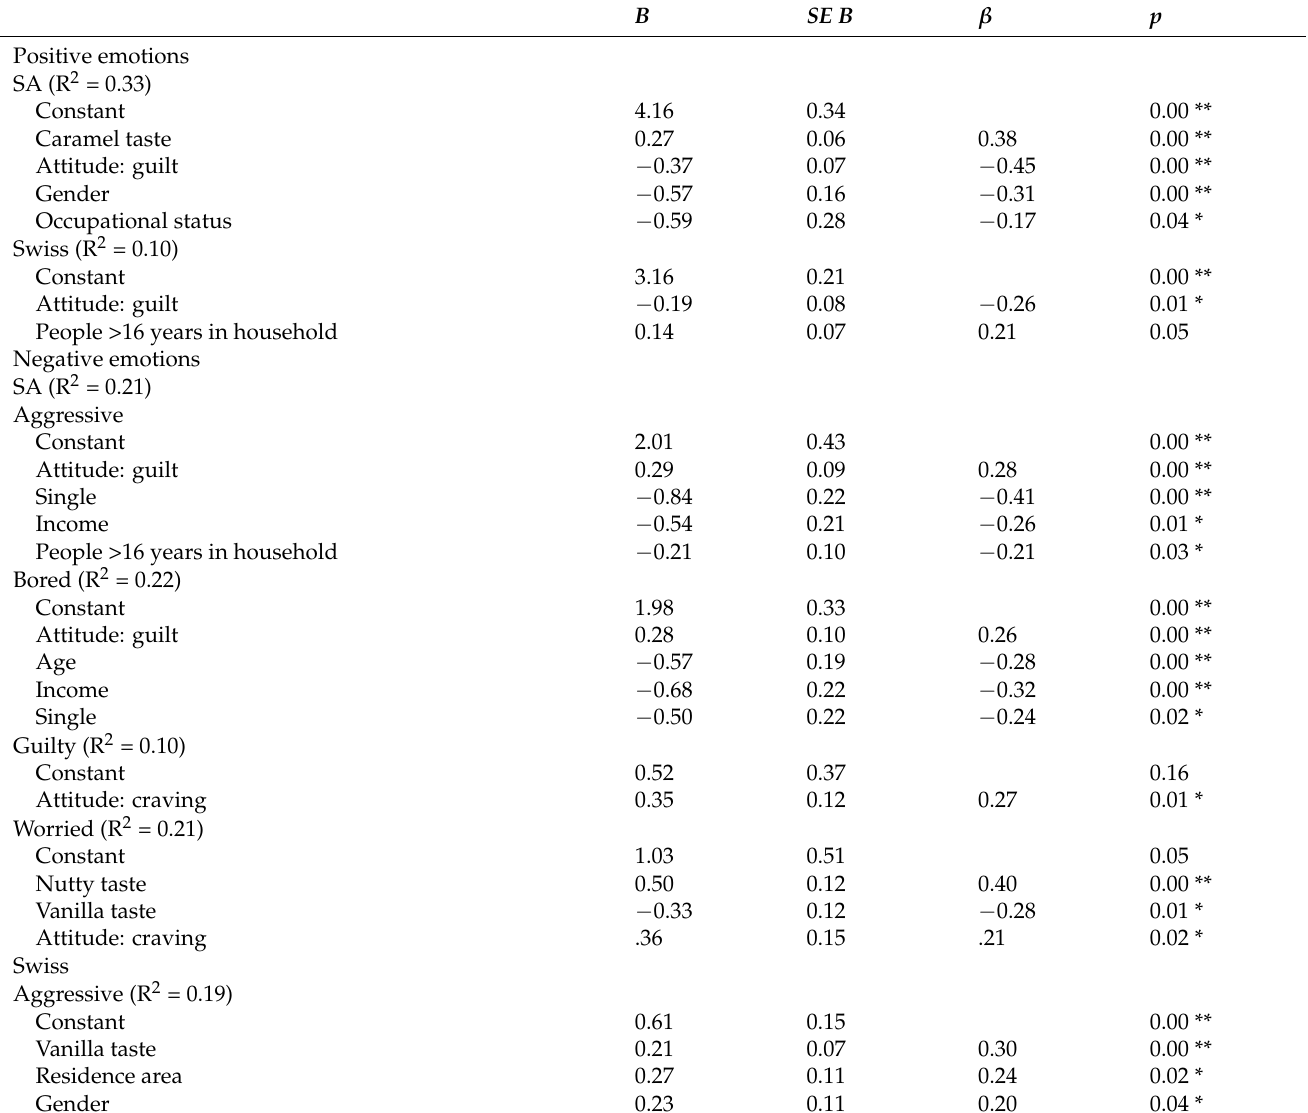
Table A3. Summary of regression analysis for variables predicting consumers’ emotions before biscuit